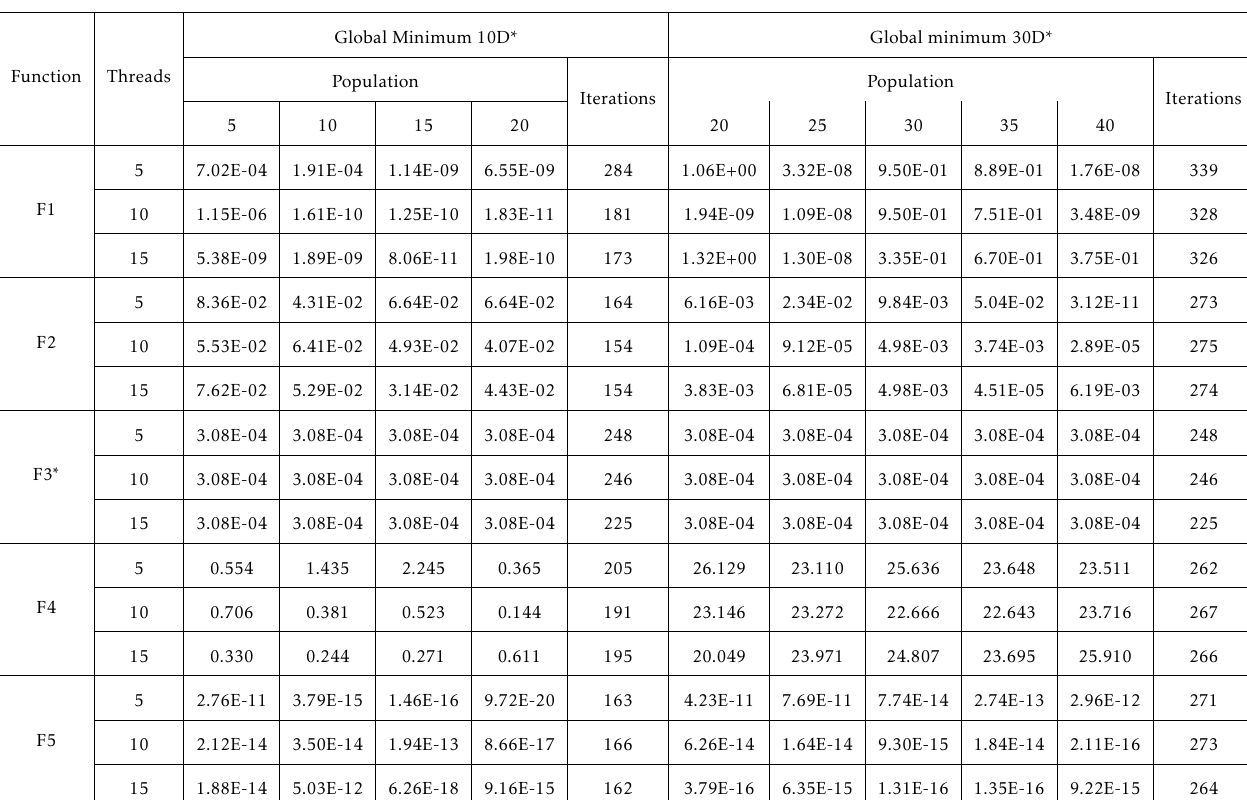
Table 7. RFO performance results in parallel with restart to the best method